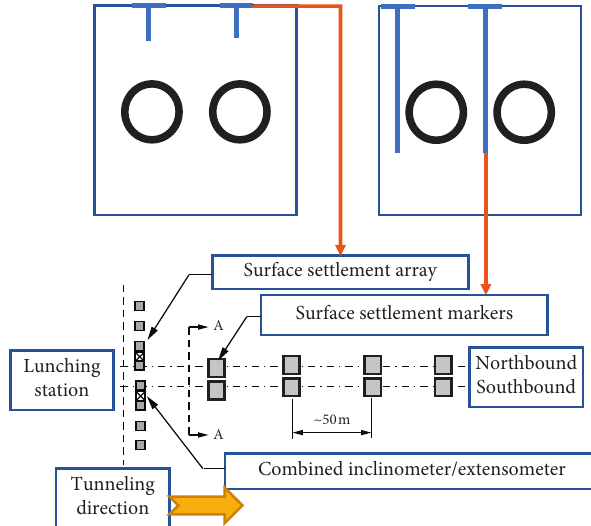
Figure 1: Typical instrumentation for ground surface settlement for the studied project.